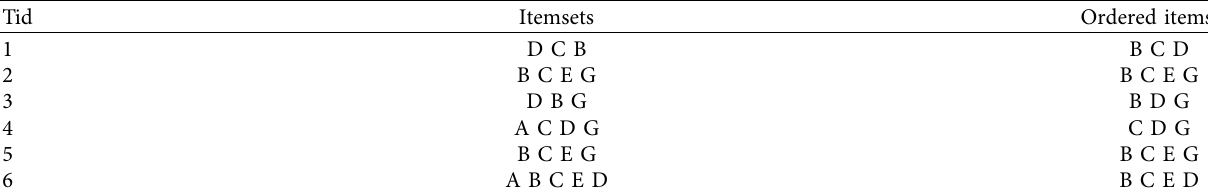
Table 6: Database D2 at T2.